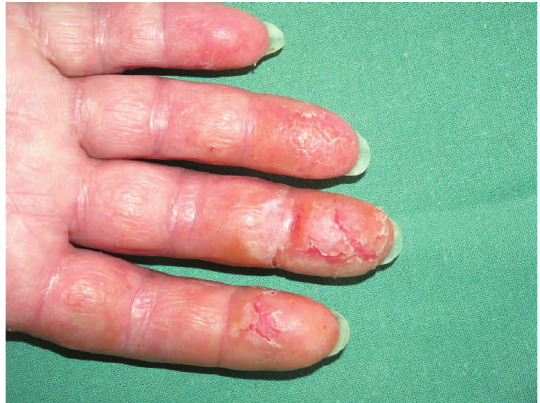
Figure 3: Pompholyx (dishidrosis).